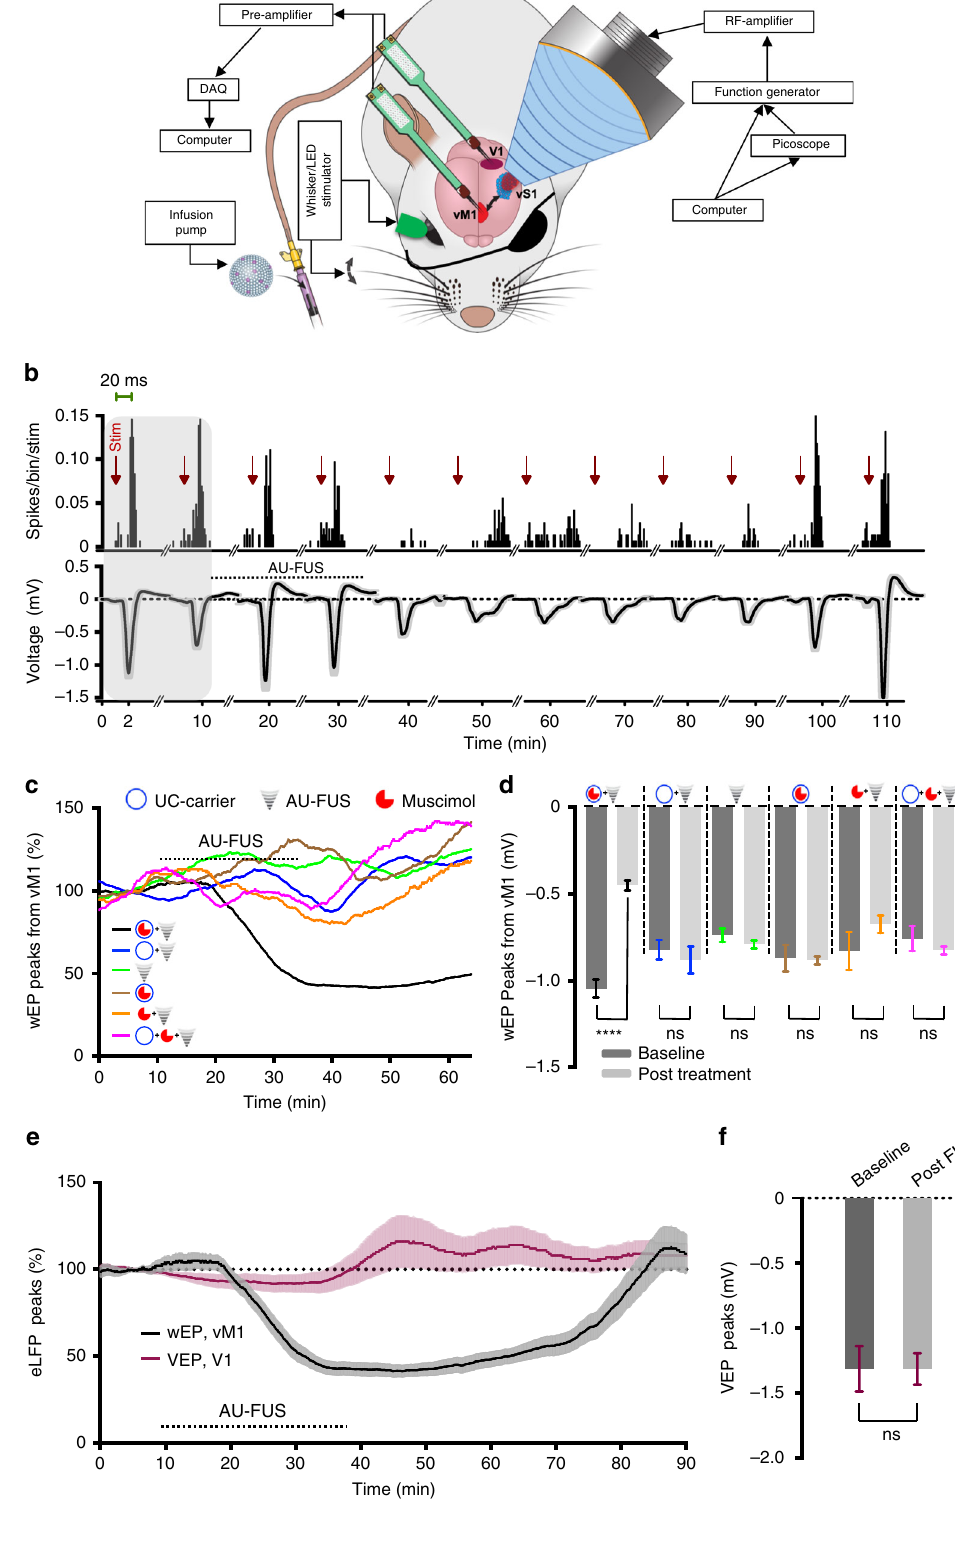
Receptor-speci fi c modulation of a cortical circuit in vivo . We tested our AU-FUS sequence in vivo (AU-FUS in-vivo ; see Table 1) by manipulating a speci fi c cortical network without opening BBB: Rat vibrissa motor cortex (vM1) receives whisker sensory infor- mation (~80%) through projections from vibrissa sensory cortex